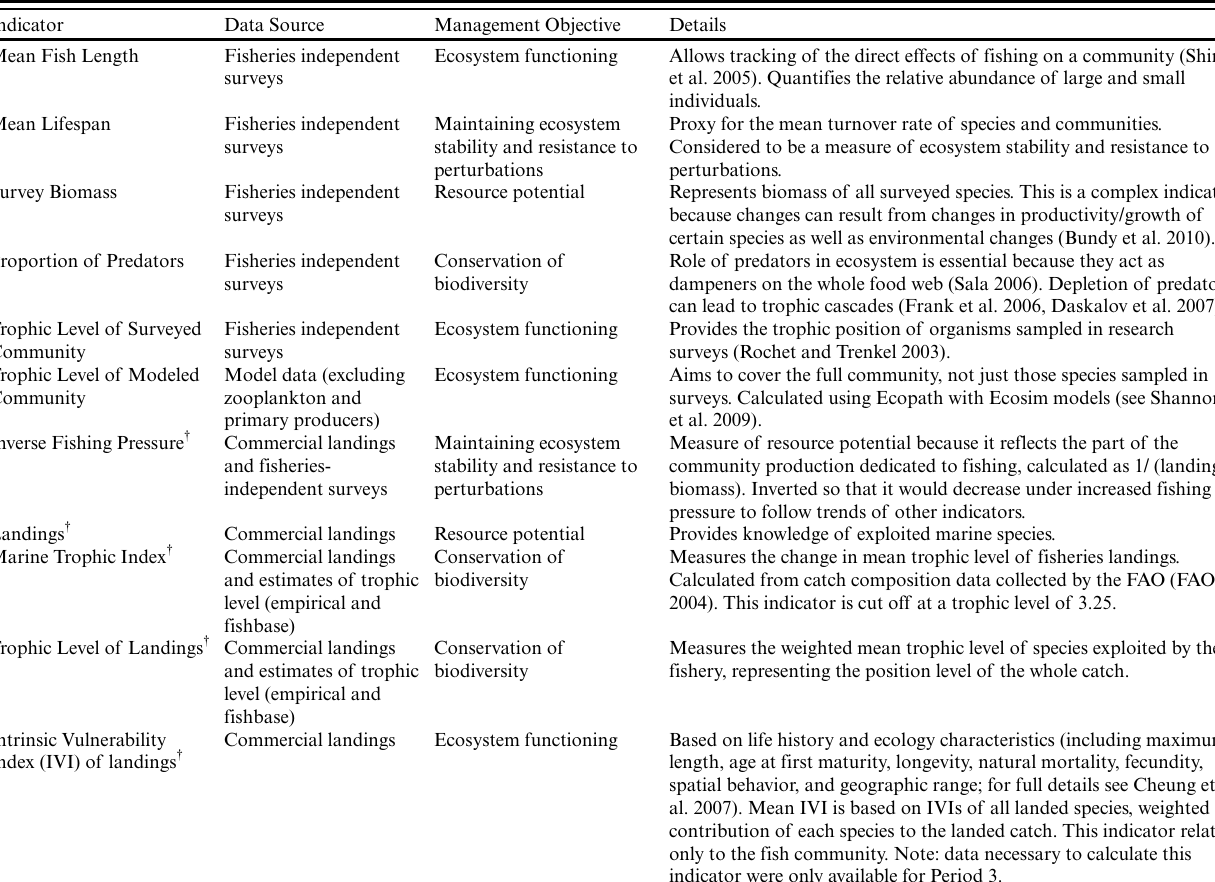
Table 1 . All IndiSeas derived indicators, including data sources, management objectives, and details of indicators (adapted from Coll et al. 2016). Daggers ( † ) indicate those indicators that were combined into an indicator of “overall fishing pressure.” Abundance and catch data provided by the Department of Agriculture, Forestry and Fisheries, South Africa and trophic level information determined from Fishbase